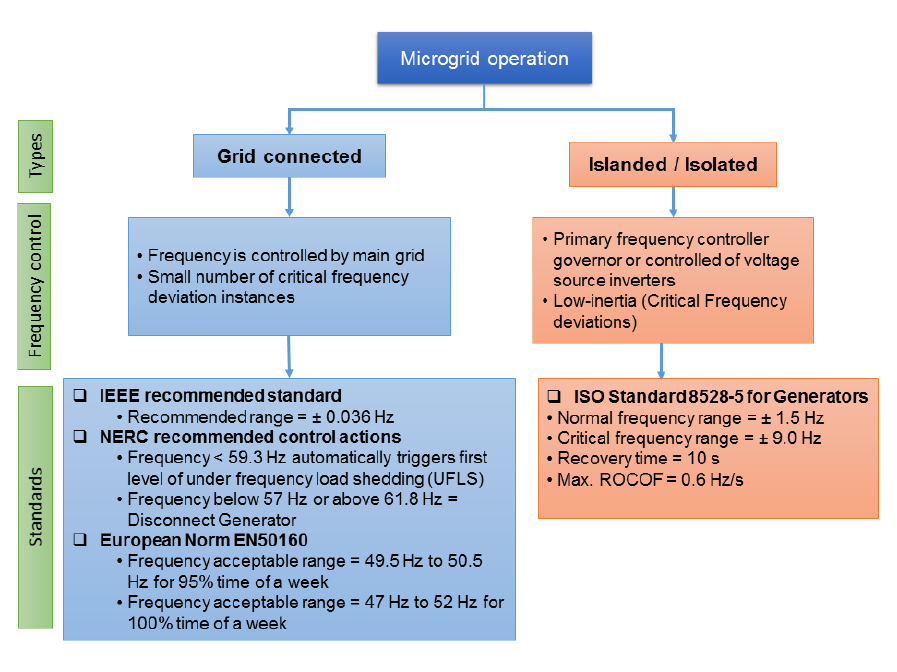
Figure 4. Frequency standards for microgrid systems